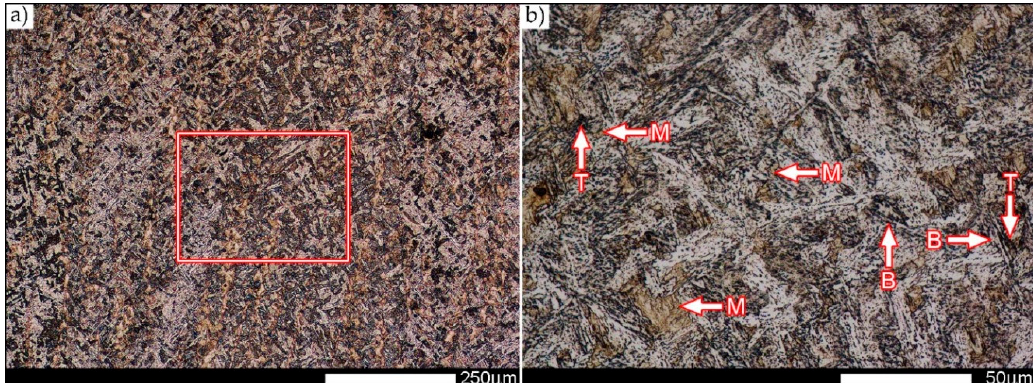
Figure 11. Microstructure of Hardox Extreme welded joint after welding: ( a ) in the area marked WM2 in Figure 5; ( b ) an enlarged image marked with frame in Figure 11a. Strongly diversified structure with dendritic nature, composed of bands of martensite (M) and bainite (B) and few colonies of troostite (T) on the grounds of hardening sorbite. Light microscopy, etched with 2% HNO 3 .